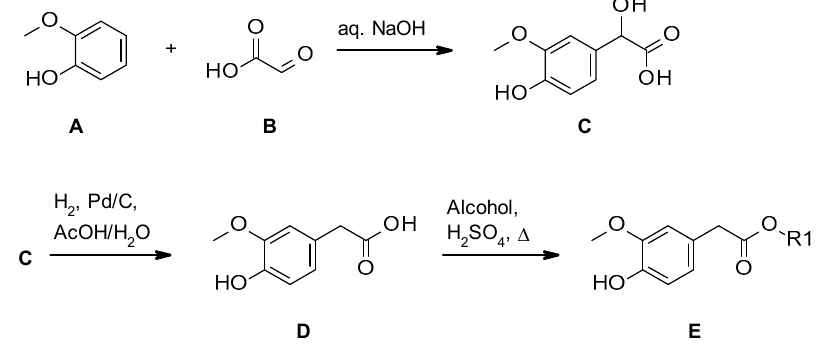
Figure 3. Schematic overview of the general synthesis to homovanillic esters D